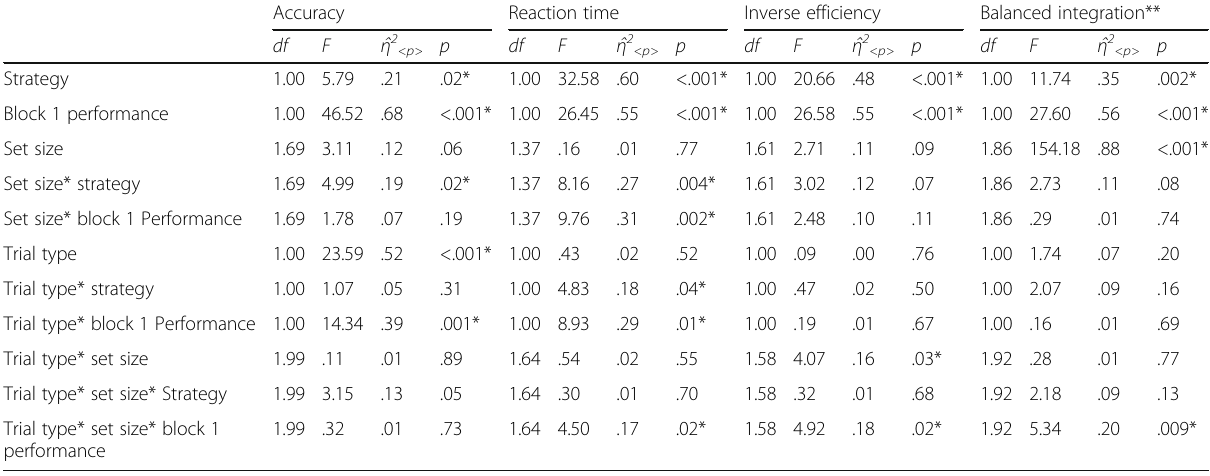
Table 2 Full results of analysis of covariance (ANCOVA) for behavioral search performance in experiment 2